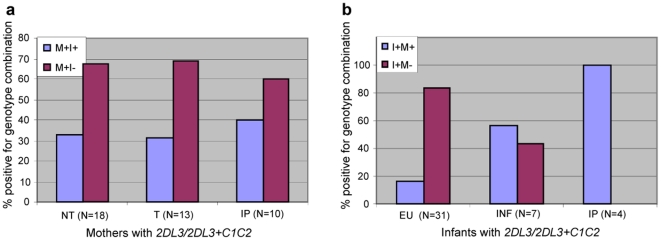
Maternal-infant concordance and discordance with respect to KIR2DL3/KIR2DL3+C1C2.
a: Percentage of mother subgroups (all harbouring KIR2DL3/KIR2DL3+C1C2) that are concordant (M+I+) and discordant (M+I-) with their respective infants for the KIR2DL3/KIR2DL3+C1C2 genotype. M: Mother; I: Infant; +: positive; -: negative; NT: non-transmitting mothers; T: total transmitting mothers; IP: intrapartum-transmitting mothers. b: Percentage of infant subgroups (all harbouring KIR2DL3/KIR2DL3+C1C2) that are concordant (I+M+) and discordant (I+M-) with their respective mothers for the KIR2DL3/KIR2DL3+C1C2 genotype. EU: exposed-unifected infants; INF: total infected infants; IP: infants infected through the intrapartum route.